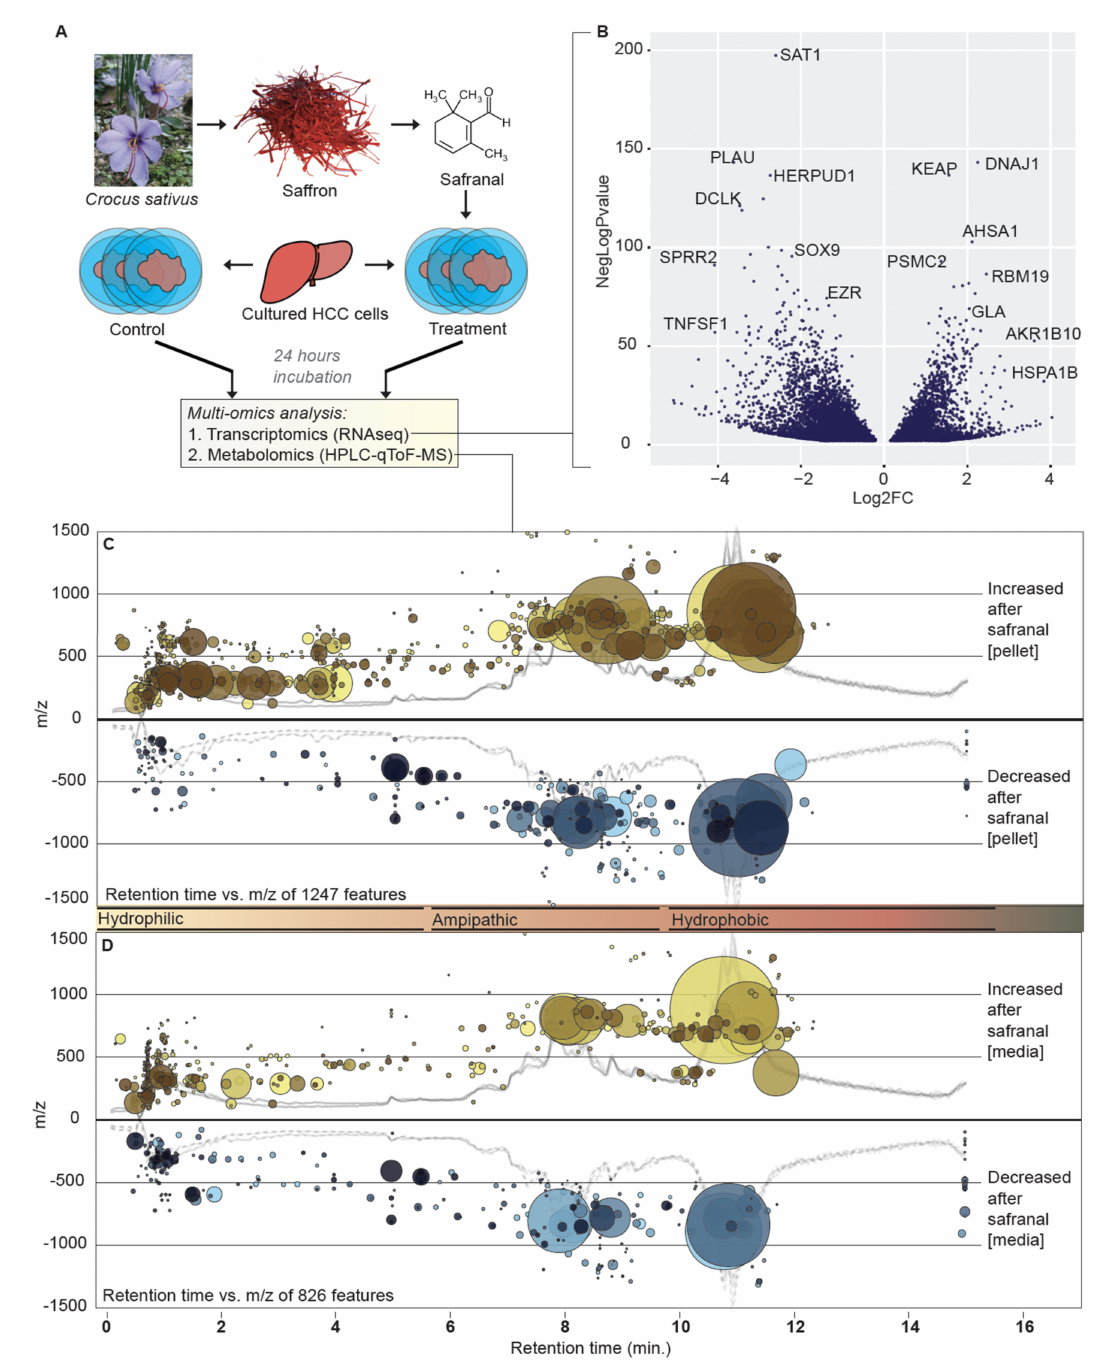
Figure 1. Overview of experiment and omics datasets. ( A ) Safranal is an active small molecule compound in saffron derived from the pistils of Crocus sativus. We performed RNAseq and HPLC– MS on extracts from safranal-treated and non-treated HCC cells. ( B ) Volcano plot showing transcript expression changes ( x -axis) and negative log p -values ( y -axis). ( C , D ) Mass-to-charge ratios ( m/z; y -axis), retention time ( x -axis), and fold-change (bubble size) of metabolites in response to safranal treatment ( p < 0.001 for all shown features) in ( C ) cell pellet extracts or ( D ) conditioned media extracts. Yellow bubbles indicate increased, and blue indicates decreased compounds in HCC pellet extracts after safranal